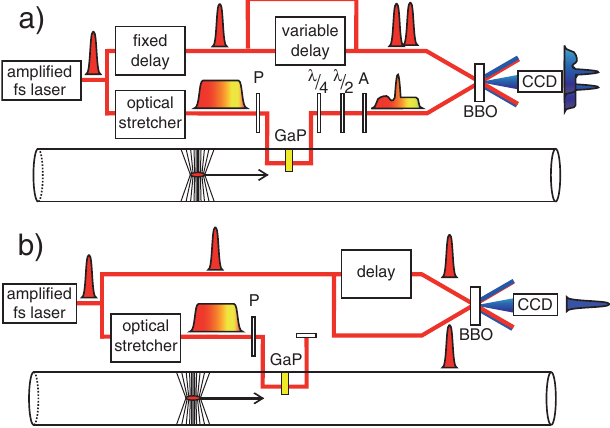
FIG. 9. (Color) Schematic drawing of the setups for calibrating the electro-optic temporal decoding (EOTD) technique. The time calibration of the EOTD system can be performed on-line as shown in (a). The time resolution of the cross-correlator setup can be determined by measuring an autocorrelation of the gate pulse as shown in (b). See text for